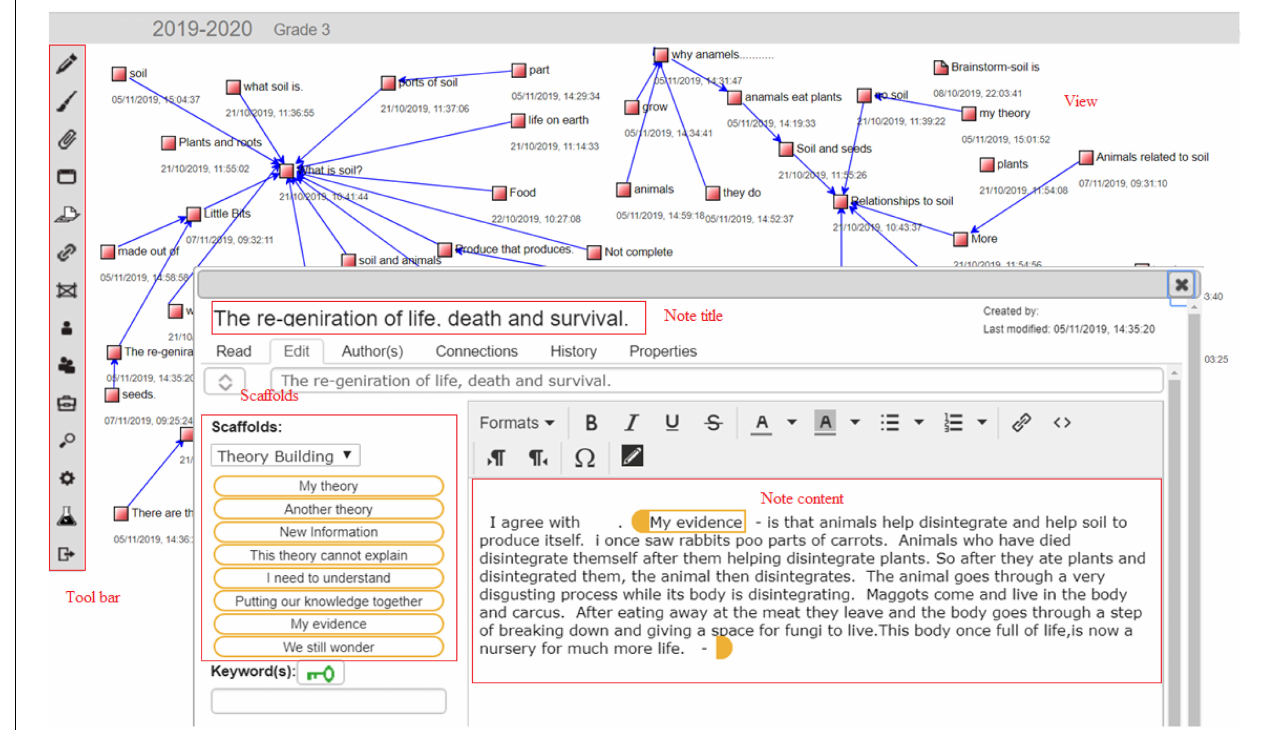
FIGURE 2 | Grade 3 Knowledge Forum view showing a note open for editing (student misspelling was not corrected).